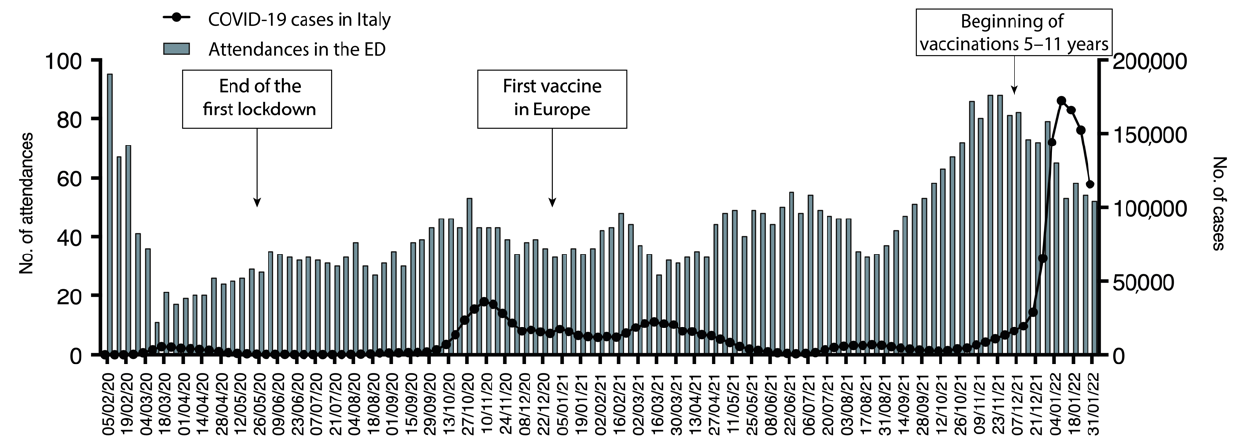
Figure 1. Representation of pediatric ED attendances from the beginning of the pandemic. Green columns represent the median number of daily attendances for each week. Line with dots represents the median number of COVID-19 cases for each week in Italy.